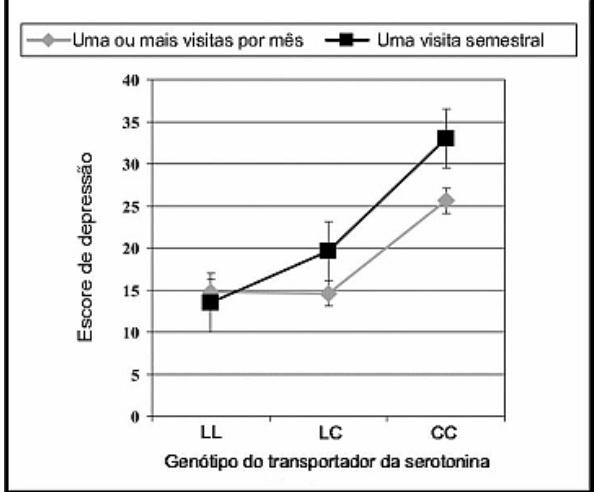
Figura 5 . Efeito da freqüência das visitas de uma pessoa responsável por desenvolver algum tipo de apoio social no escore de depressão em crianças que receberam maus tratos na infância com diferentes genótipos à molécula de transporte da